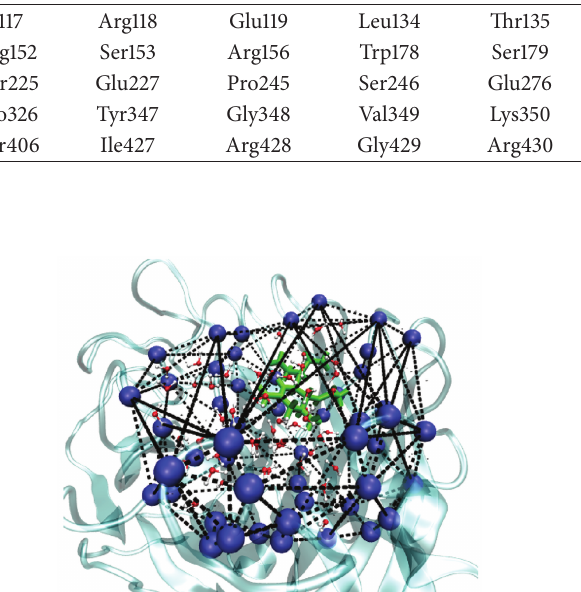
Table 2: List of 50 residues surrounding the binding site.